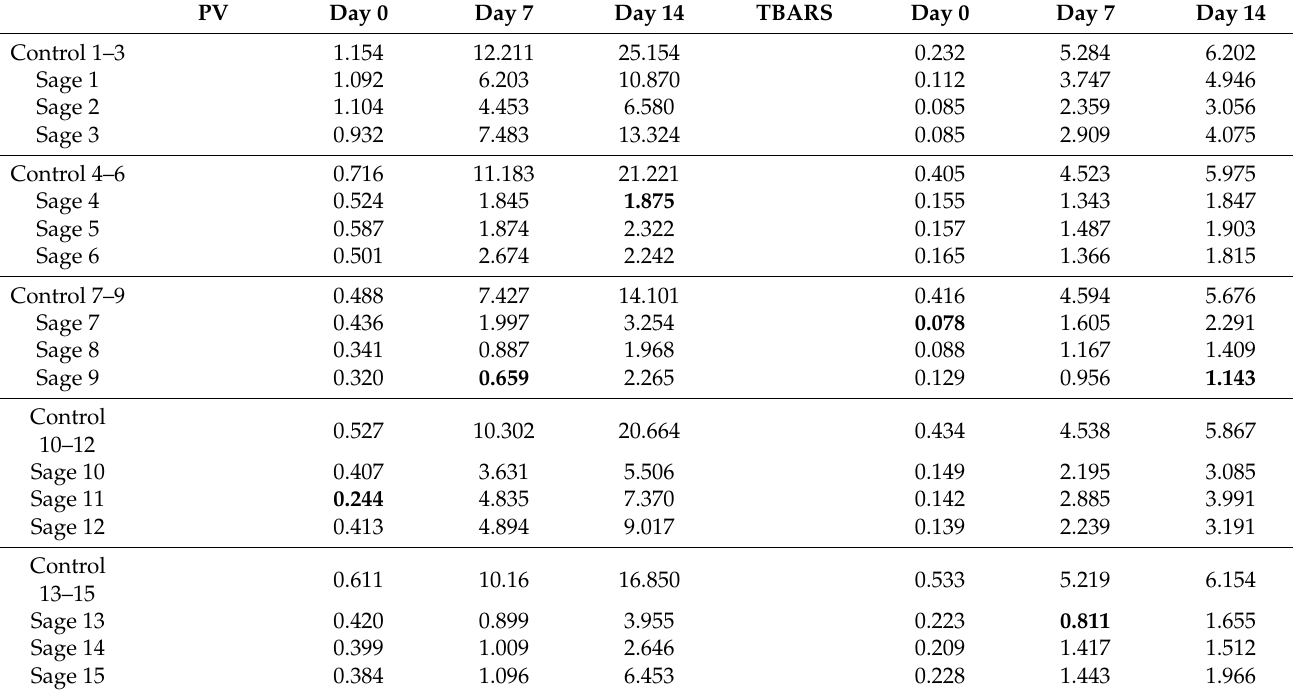
Table A2. Peroxide value (PV) (active O 2 in 1/8 mmol/kg meat) and thiobarbituric acid reactive substances (TBARS) (mg malondialdehyde/kg meat) after 0, 7, and 14 days of refrigerated storage for cooked beef/pork samples with added sage. The sage sample with the lowest PV and TBARS, respectively, at each time point is marked in